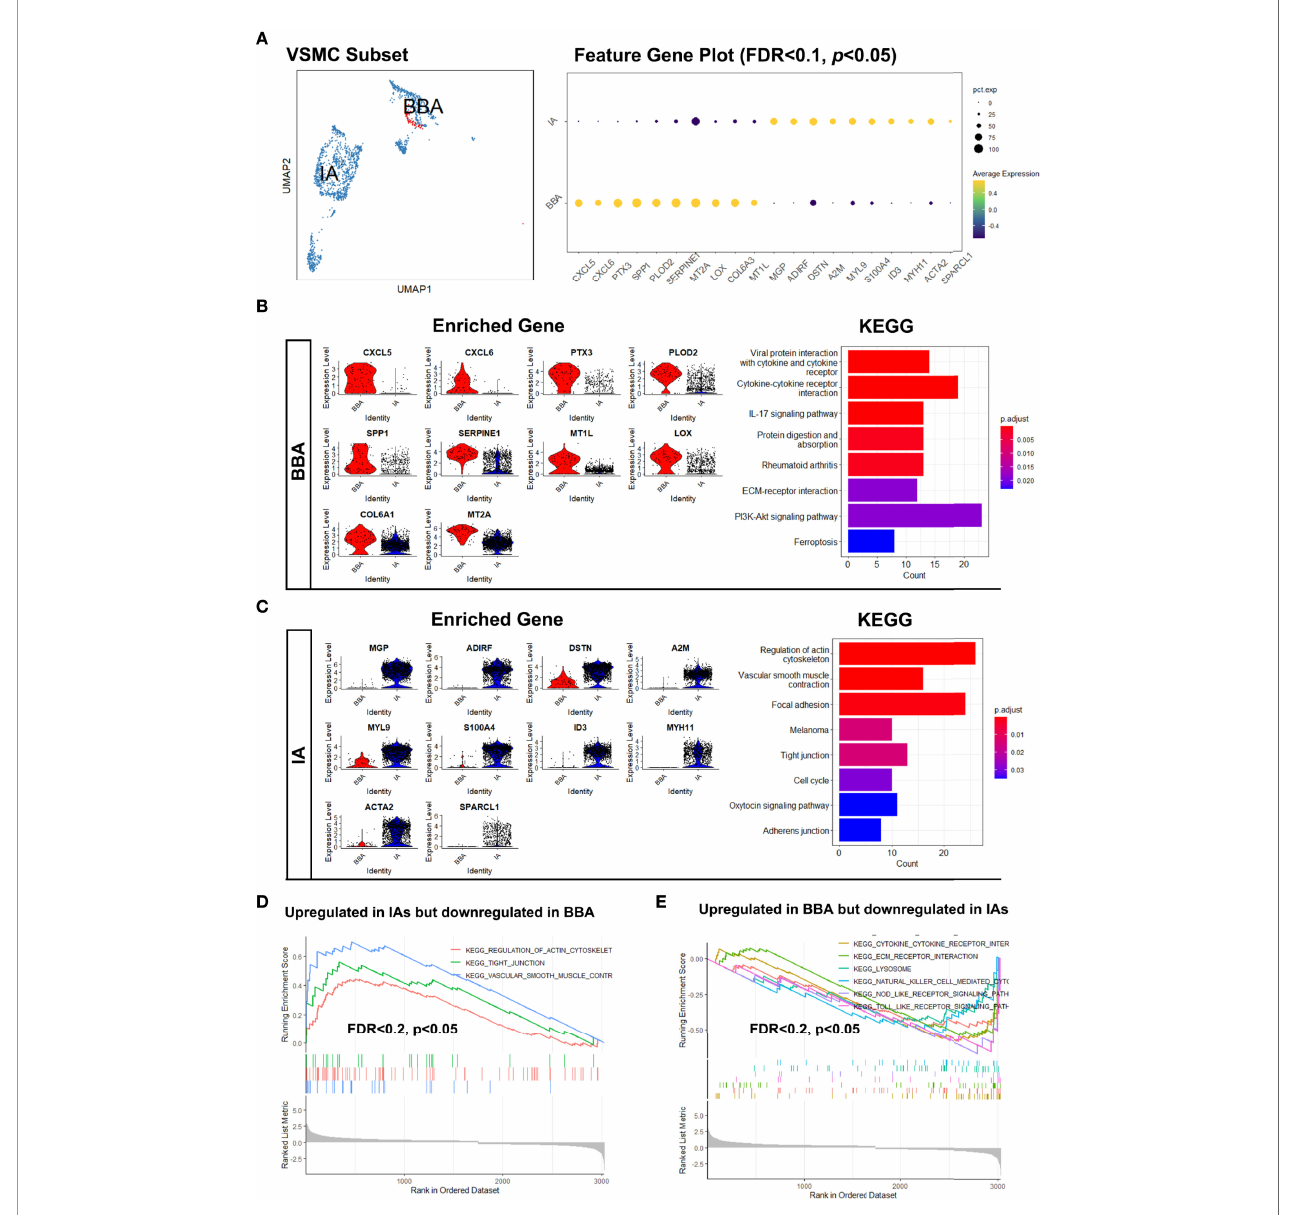
FIGURE 2 | Distinct distribution of vascular smooth muscle cells (VSMCs) in blood blister-like aneurysm (BBA) and intracranial aneurysms (IA). (A) The different distributions of VSMCs in uniform manifold approximation and projection and differentially expressed genes. (B) Transcriptional features and enriched cellular signaling pathway of BBA-derived VSMCs. (C) Transcriptional features and enriched cellular signaling pathway of IA-derived VSMCs. (D, E) Upregulated signaling pathways in BBA and IAs pro fi led in gene set enrichment